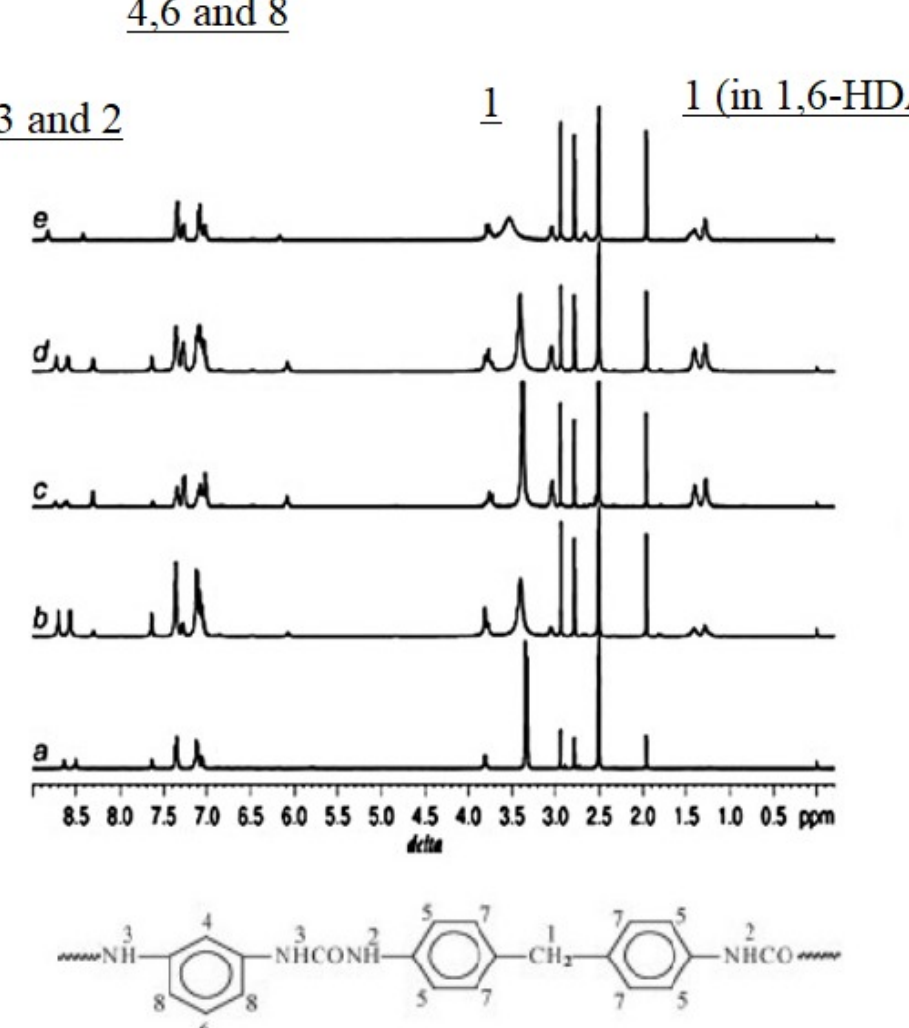
Figure 19. H-NMR spectra of the polyurea samples. From reference [42]. Oligomers have a special molecular structure and limited molecular mass consti- tuted of a set of similar or different units that are repeatedly connected with each other.